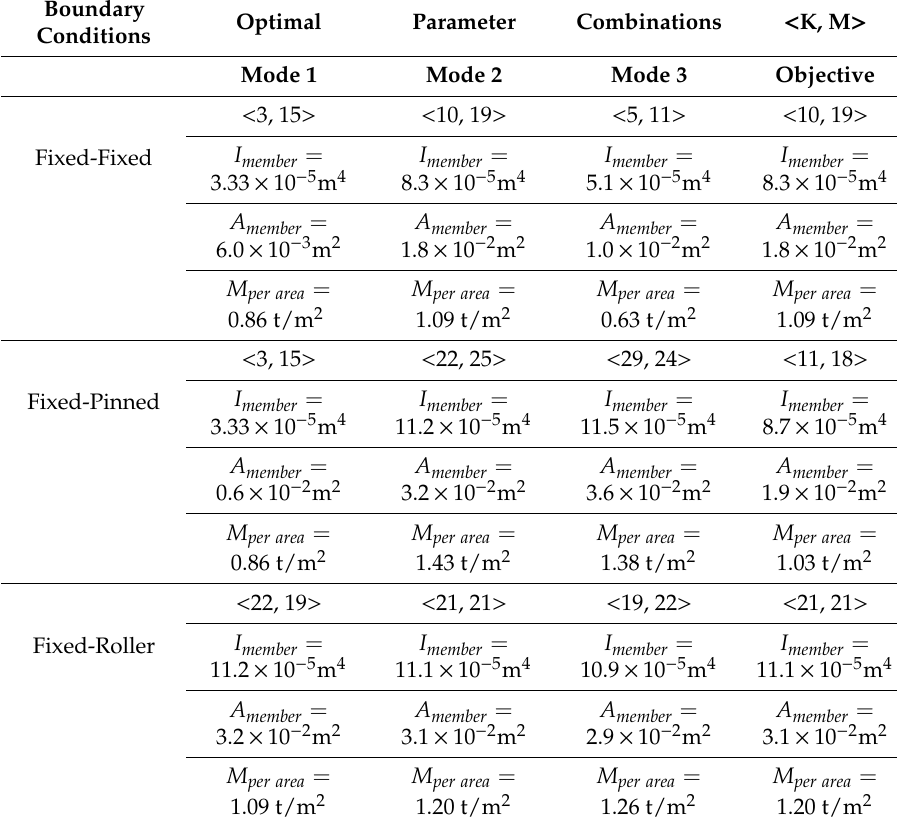
Table 1. Optimal models for di ff erent